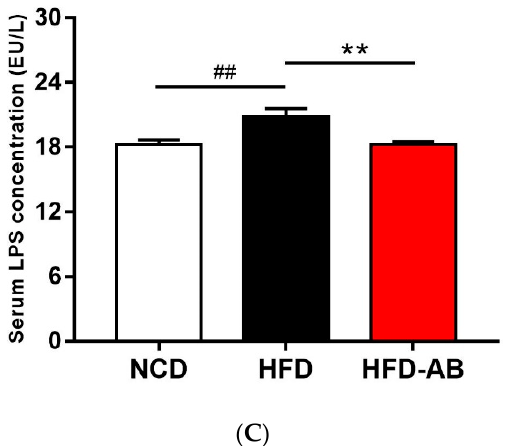
Figure 2. Effects of adzuki bean supplementation on the serum parameters of mice. ( A ) The concentration of triacylglycerol (TG), total cholesterol (TC), high-density lipoprotein cholesterol (HDL-C), and low-density lipoprotein cholesterol (LDL-C); ( B ) serum ALT and AST levels; and ( C ) serum LPS level. Data are shown as mean ± SEM of 7 mice per group. ## p < 0.01, HFD compared with NCD mice. * p < 0.05 and ** p < 0.01, HFD-AB compared with HFD mice. NCD, normal control diet; HFD, high-fat diet; HFD-AB, high-fat diet supplemented with adzuki bean.